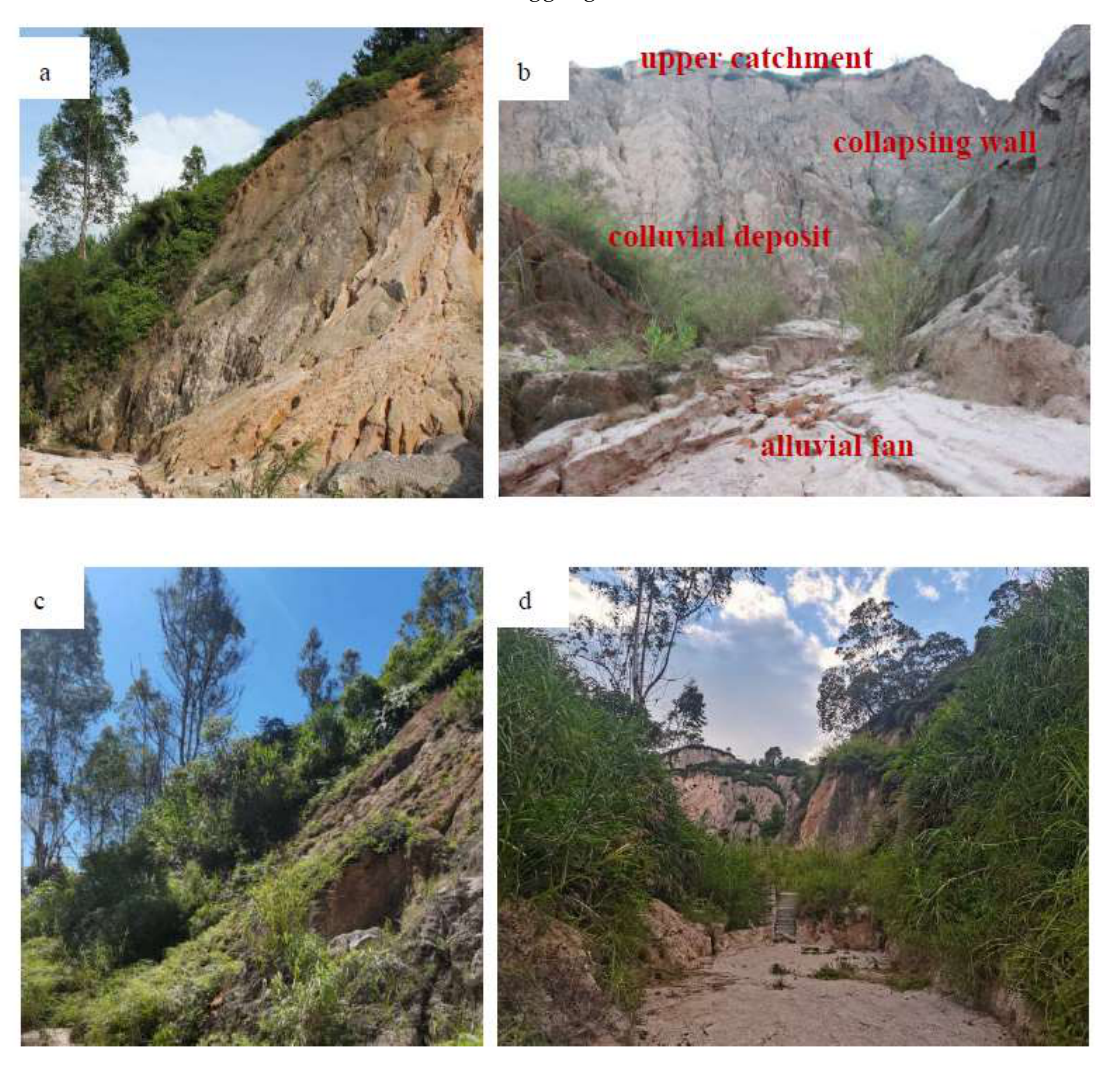
Figure 1. Photo of Benggang in the study area. ( a , b ) The Benggang scene before the treatment in 2012; ( c , d ) The Benggang scene after the treatment in 2020.